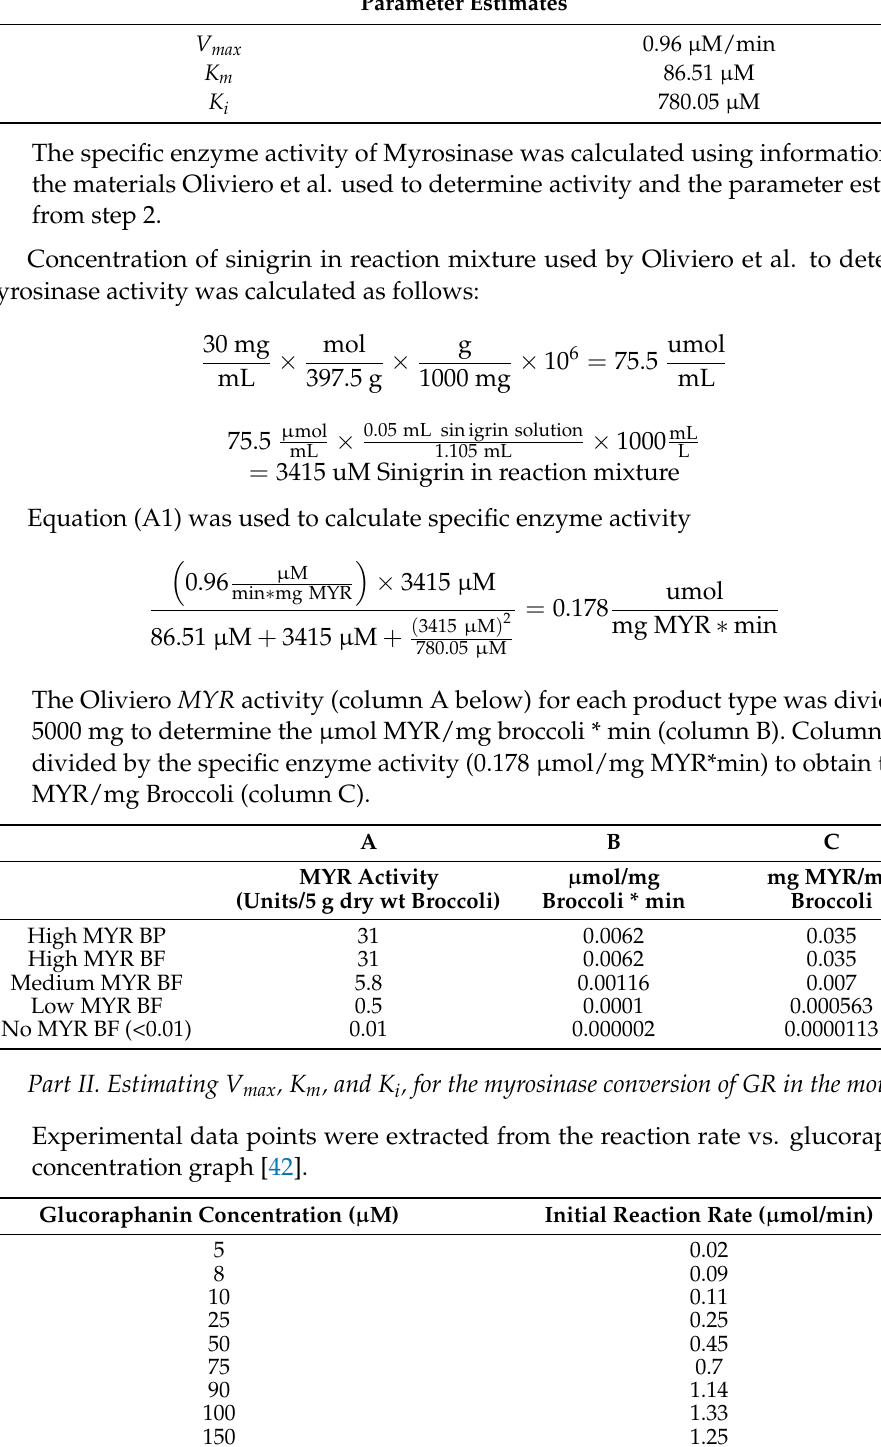
Parameter Estimates